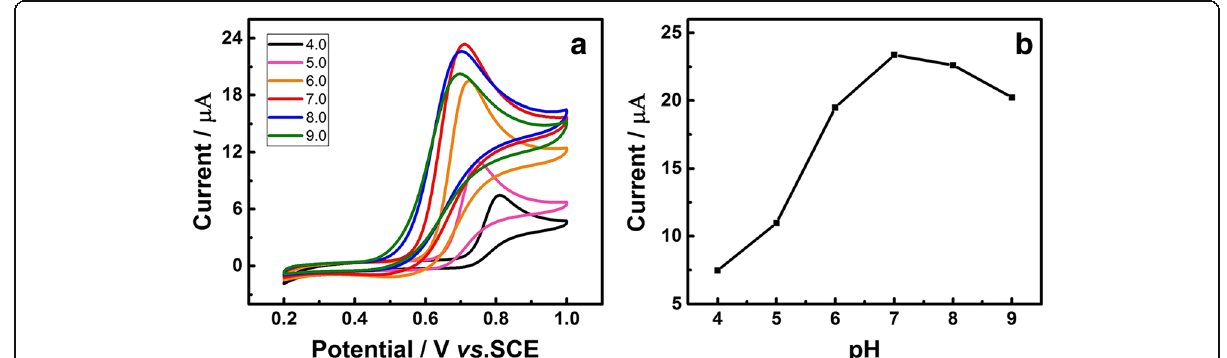
Fig. 5 a CVs of the Au/GCE in 1 mM UA with different pH PBS solution (pH=4.0, 5.0, 6.0, 7.0, 8.0, and 9.0), scan rate 50 mV s − 1 . b Relationship between the oxidation peak current and pH value